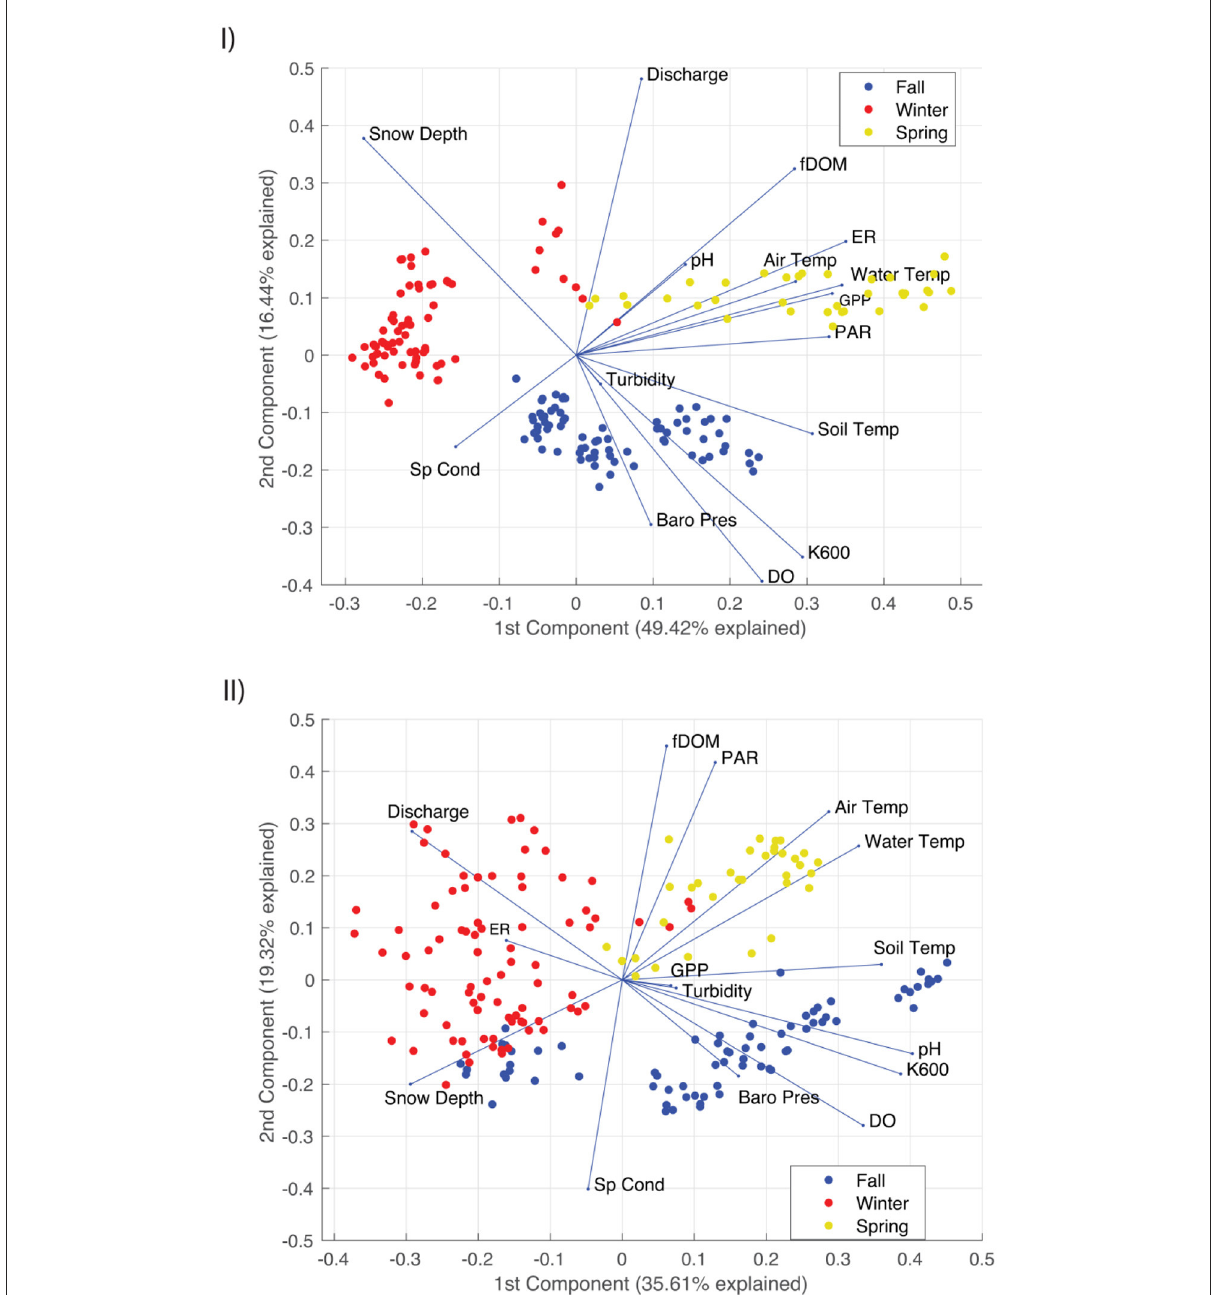
FIGURE5 PCA biplot for daily averaged data for the (I) 2018–2019 El Niño and (II) 2020–2021 La Niña years. Parameters plotting in the same direction are positively correlated, those in opposite directions are negatively correlated, and those that are orthogonal are uncorrelated. Principal components one and two explained (I) 65.86% and (II) 54.93% of the total variation. Score values were added to the PCA biplot and are color-coded based on their respective period of analysis.